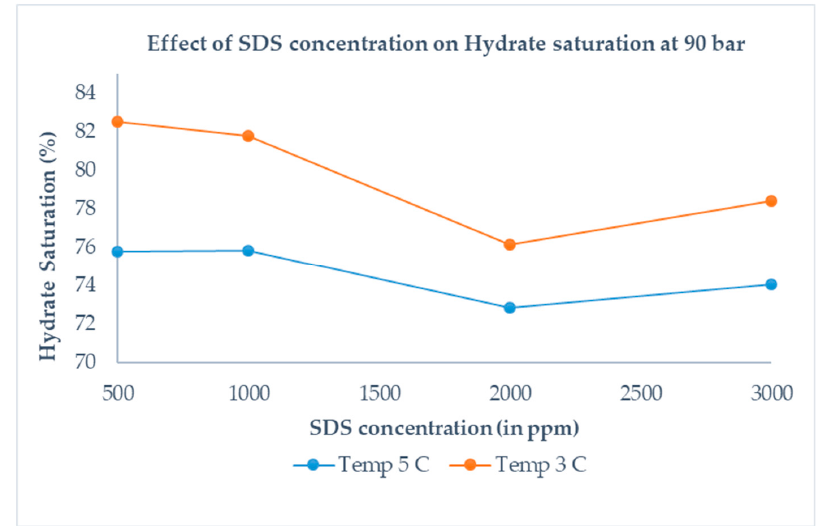
Figure 12. Hydrate saturation vs. SDS concentration at 3 °C and 5 °C for fresh sample and initial pressure of 90 bars. At lower operating temperature, higher hydrate saturation is observed, which changes around the expected CMC concentration.